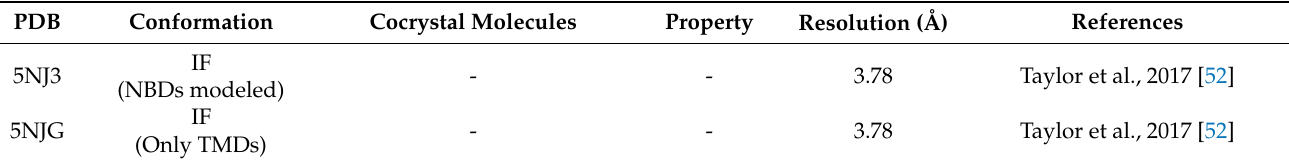
Table 1. Summary of cryo-EM structures of human ABCG2. All structures collected in this stable are exclusively solved via